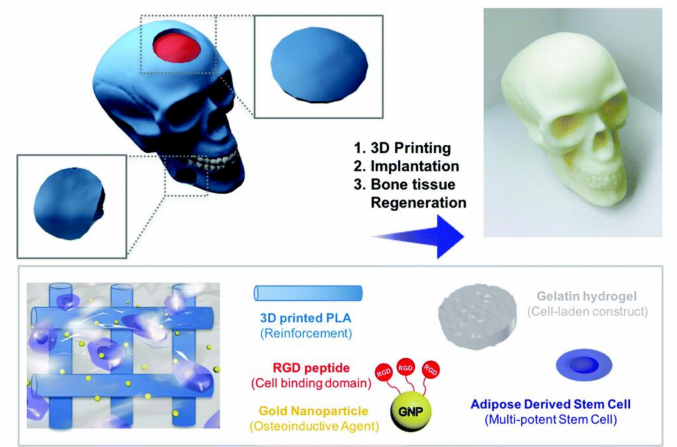
Figure 7. Patient-specific bone tissue regeneration using 3D-printed PLA incorporated with a hybrid gelatin hydrogel composed of gold nanoparticles and human adipose-derived stem cells (Reproduced with permission from Reference [93], copyright 2017, The Royal Society of